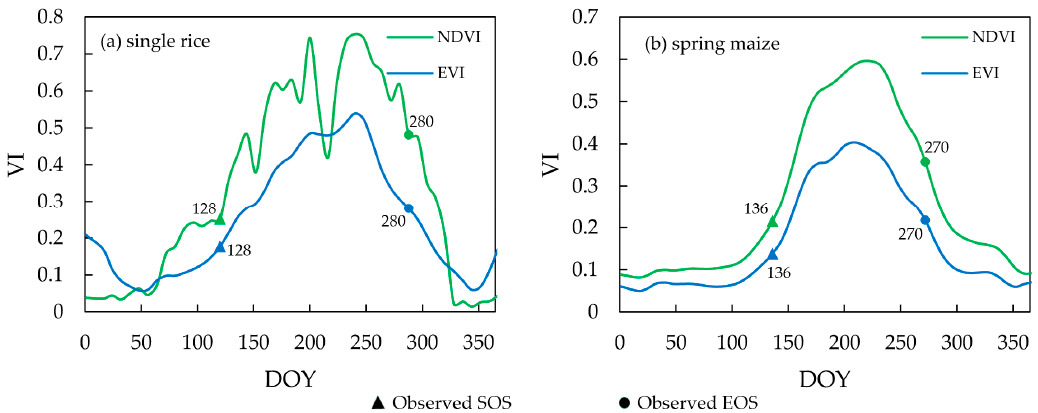
Figure 11. Examples of Normalized Difference Vegetation Index (NDVI) (in green) and Enhanced Vegetation Index (EVI) time series (in blue) of (a) single rice and (b) spring maize.